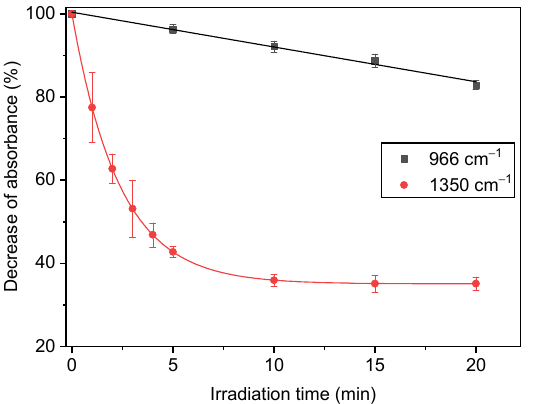
Figure 3. Absorbance decline of two FTIR bands in 90 wt-% ABS/10 wt-% DBDE film, relative to their initial values.